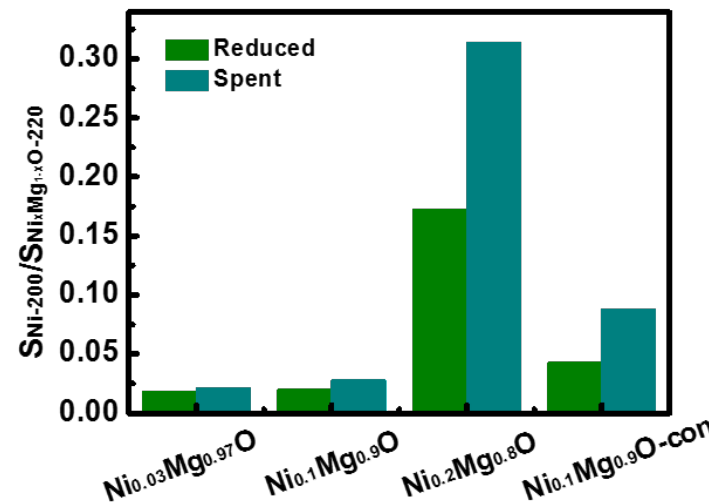
Figure 7. (a) The XRD patterns of the Ni x Mg 1−x O catalysts reduced at 800 °C by H 2 . (b) XRD patterns of the Ni x Mg 1−x O catalysts after the continuous CRM reaction at 700 °C for 36 h.